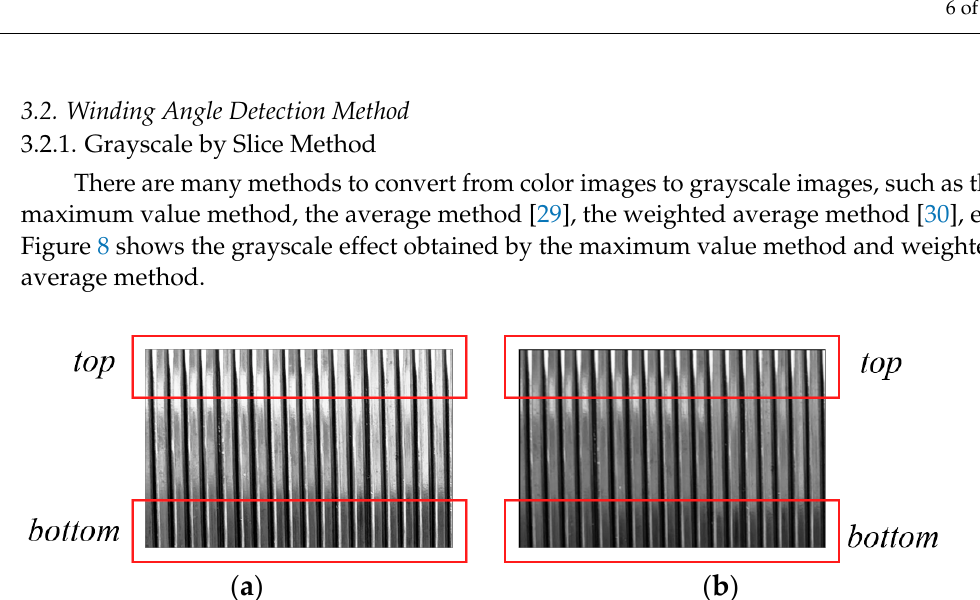
Figure 7. Median filter effect: ( a ) images containing noise; ( b ) median filtering; ( c ) mean filtering; ( d ) Gaussian filtering.